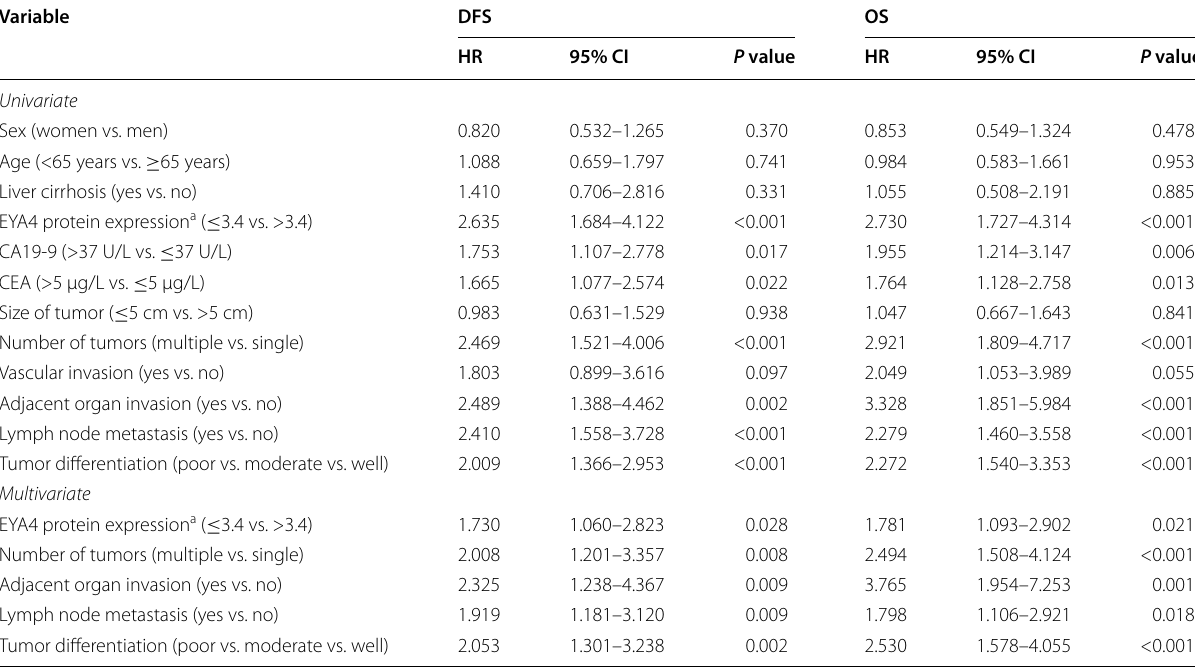
Table 1 Prognostic factors for DFS and OS of patients with intrahepatic cholangiocarcinoma determined by using uni- variate and multivariate Cox regression models